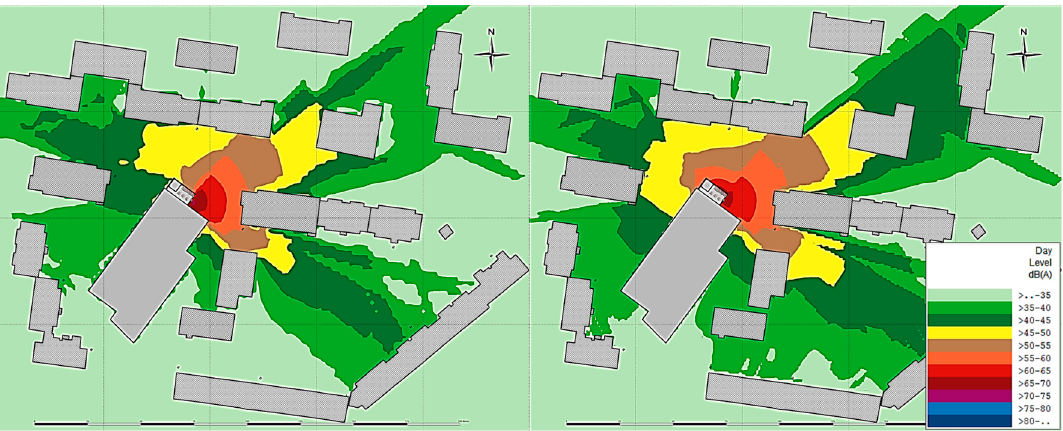
Figure 5. Scenario 1 with no technical solution—Lday with all noise sources ( left : 4 m, right : 10 m).